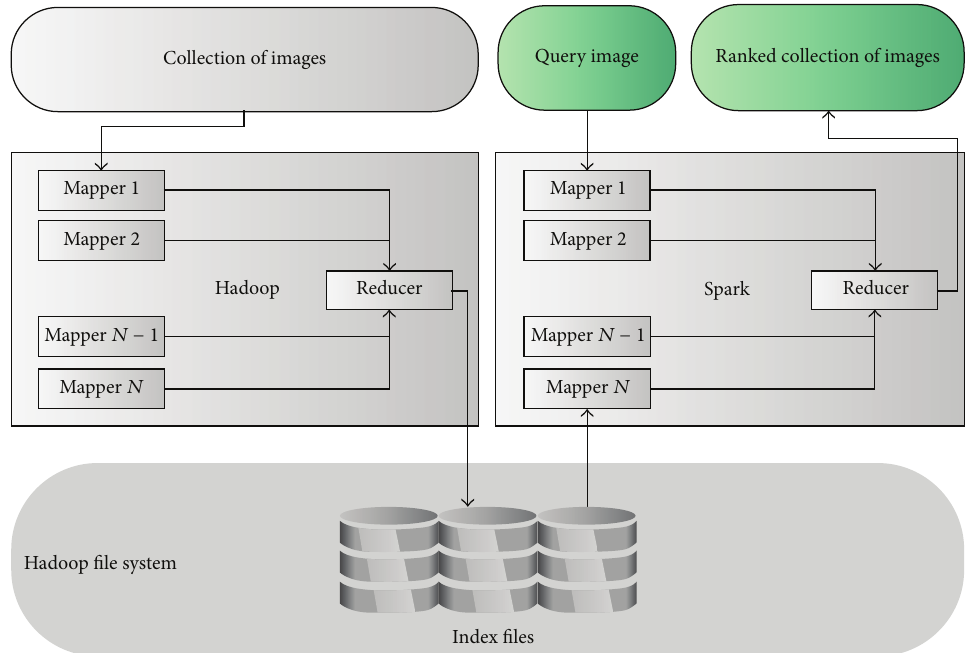
Figure 1: Architecture of the system. The gray objects represent the server side, while the green objects represent the client side.